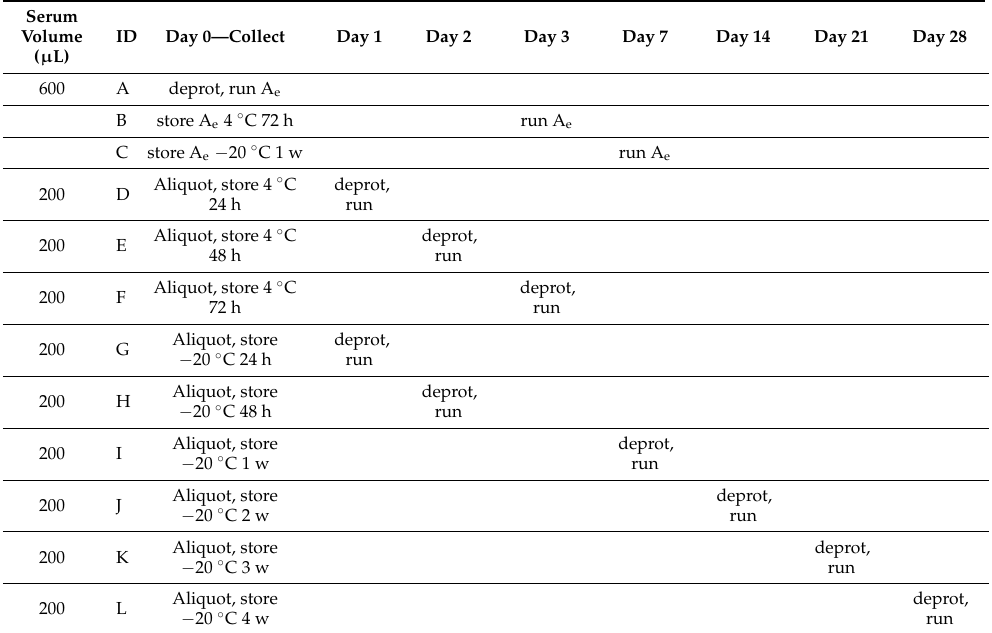
Table 2. Short-term stability study